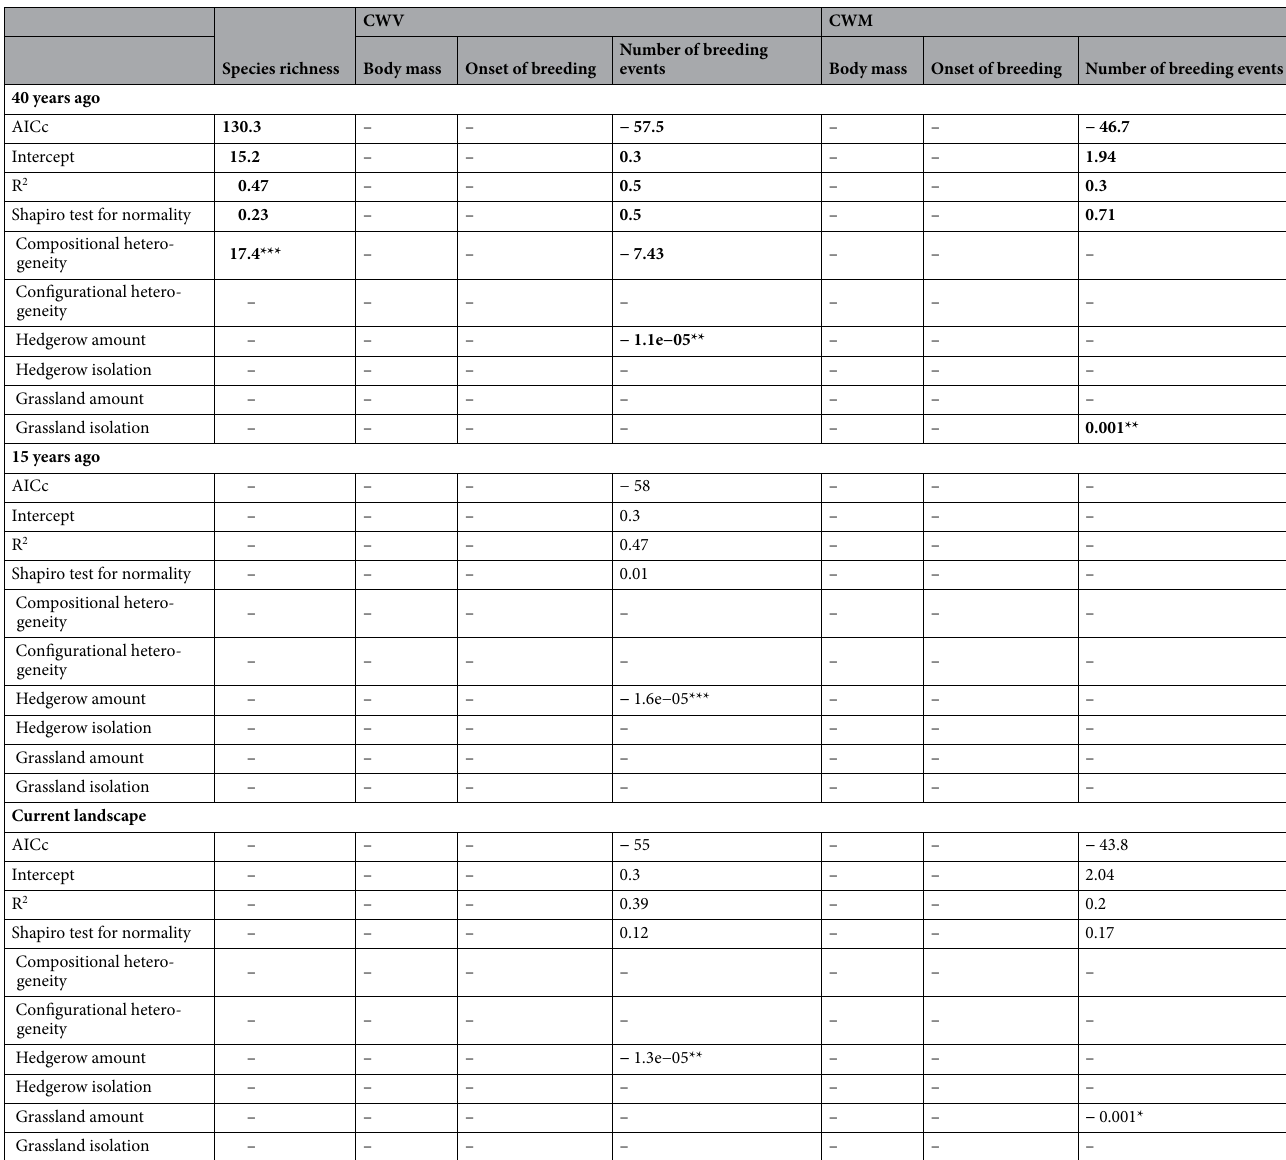
Table 4. Results of linear models testing the effect of landscape predictors on species richness, community weighted variance (CWV) and community weighted mean (CWM) of each trait, calculated from the occurrence rate of bird assemblages. AICc, intercept, R 2 and Shapito test for normality of residuals of each significant model are indicated. Estimates of the landscape predictors and their significance levels (***p < 0.001, **p < 0.01, *p < 0.05) are indicated. Non-significance of models and landscape predictors (−) are